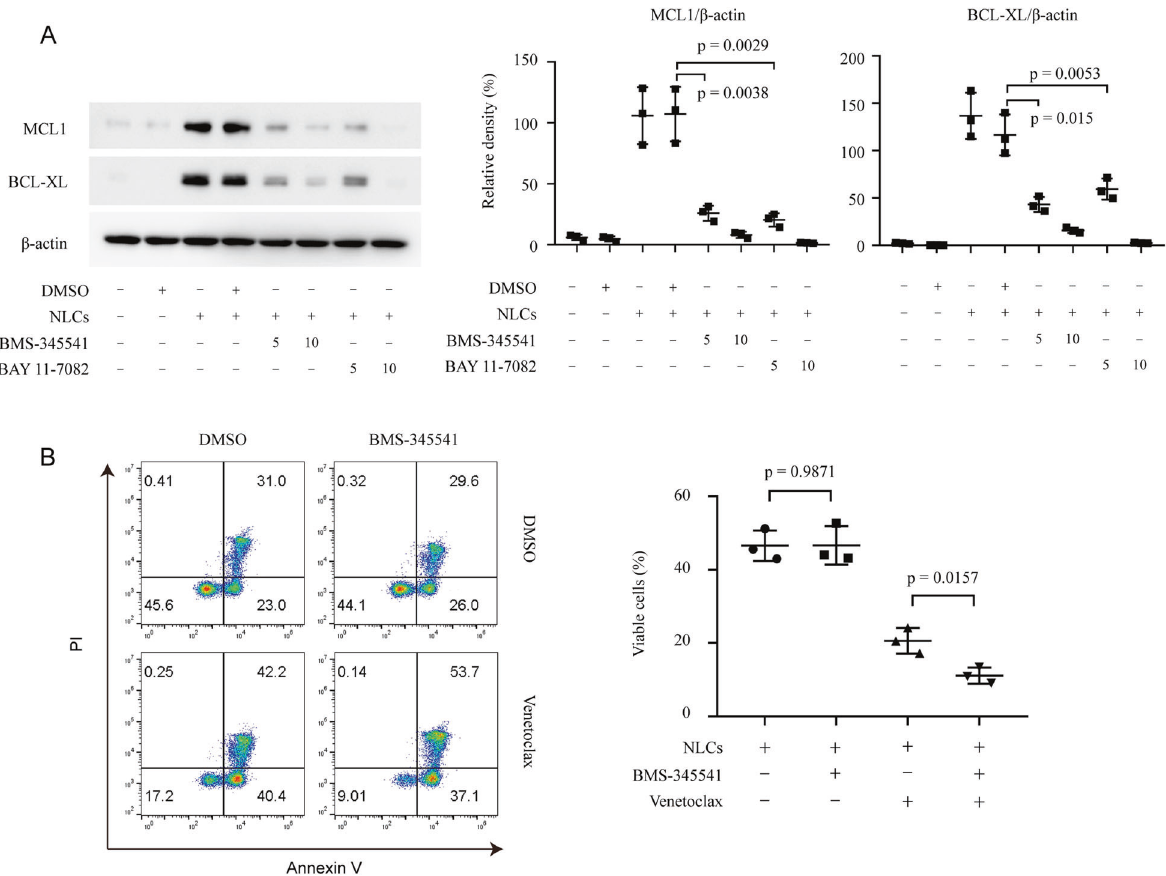
Fig. 6 NF- κ B activation is required in NLCs-induced resistance to venetoclax in CLL cells. A Immunoblot analysis of MCL1 and BCL-XL in lysates of CLL cells with or without NLCs treated by BMS-345541 or BAY 11 – 7082. Bar fi gures represent ratios of densities (MCL1/ β -actin and